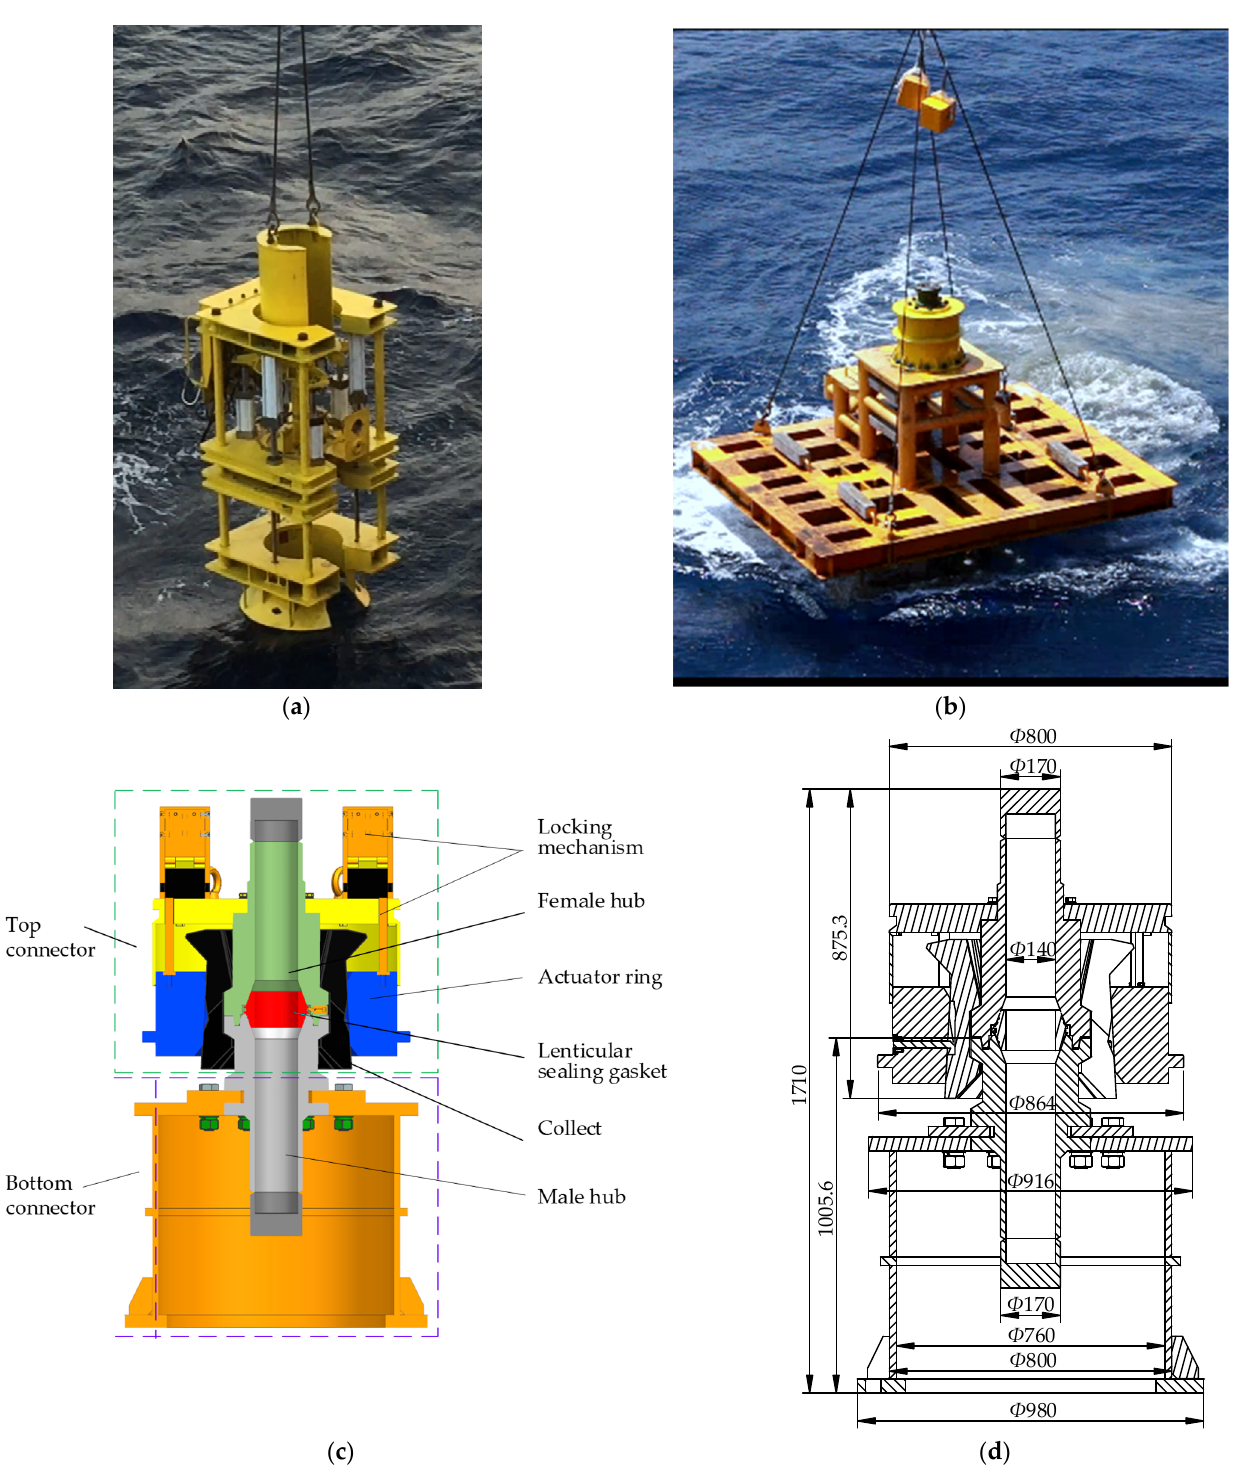
Figure 1. Subsea Connector. ( a ) Installation tool and top connector; ( b ) the base and bottom connector; ( c ) the key structure of the subsea connector; ( d ) drawing of the connector with the dimensions.